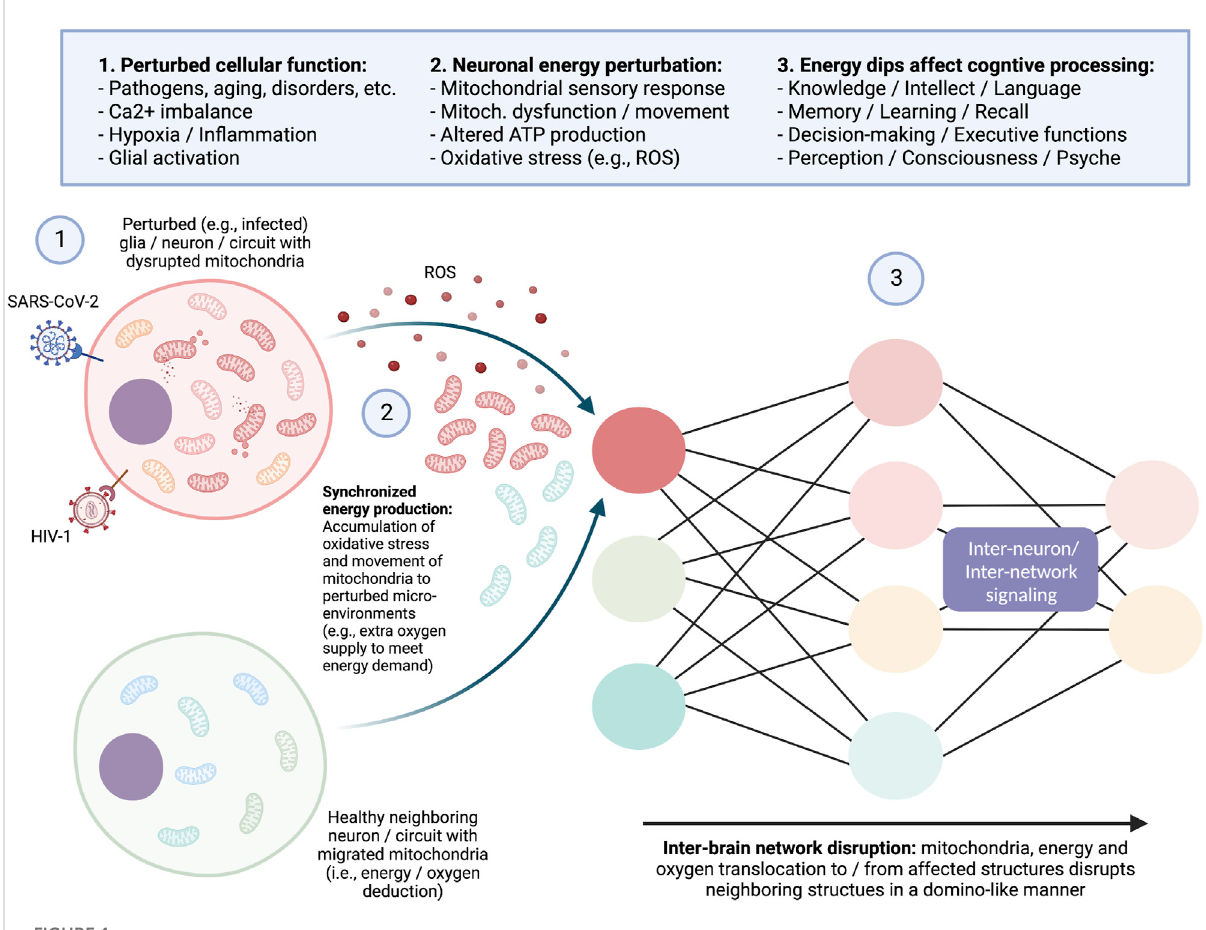
FIGURE 1 Importance of mitochondrial energy production for functional